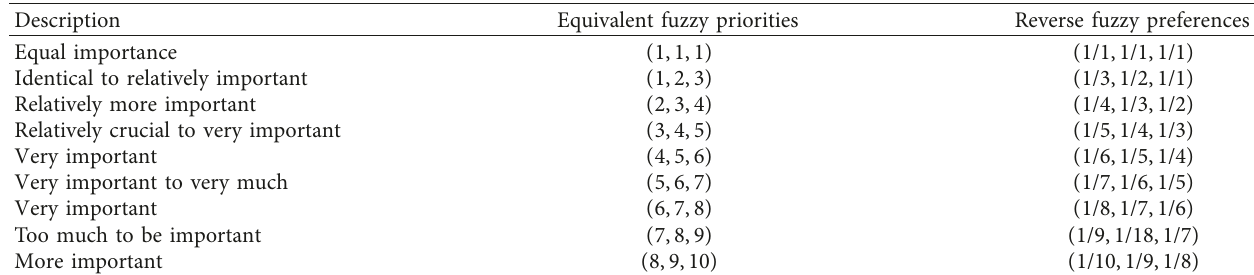
Table 2: Nine spectra of fuzzy